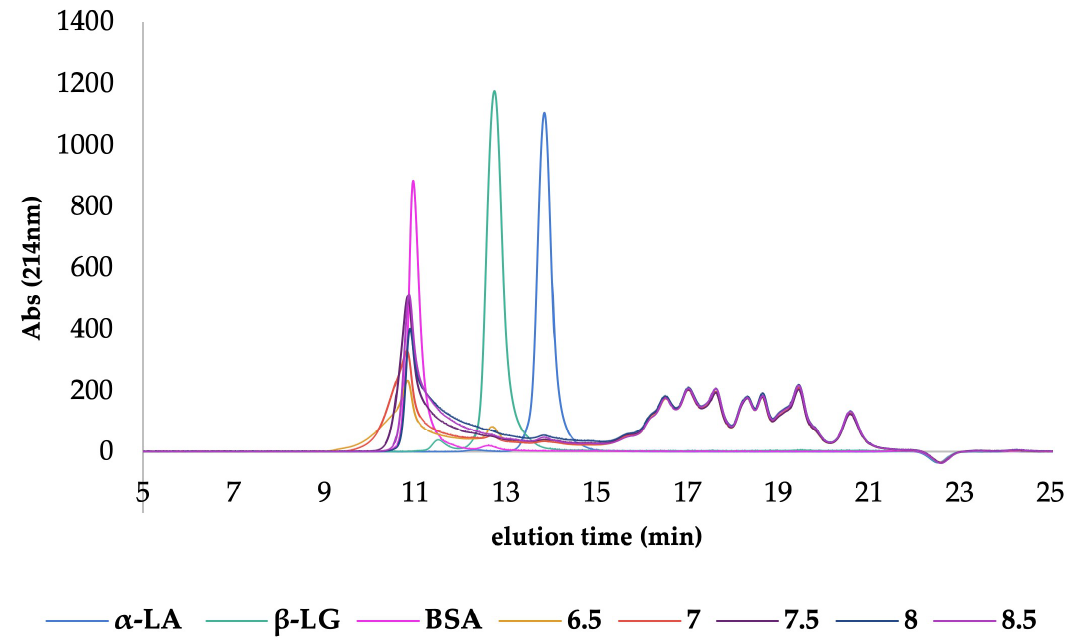
Figure 4. High-performance liquid chromatography‒size exclusion (HPLC-SEC) profiles, representing the effect of continuous heat and holding (HTST-EHT) treatment using a heat exchanger on selectively hydrolysed whey protein isolate samples held at different pH values. Protein standards: α-lactalbumin (α-LA), β-lactoglobulin (β-LG), and bovine serum albumin (BSA).